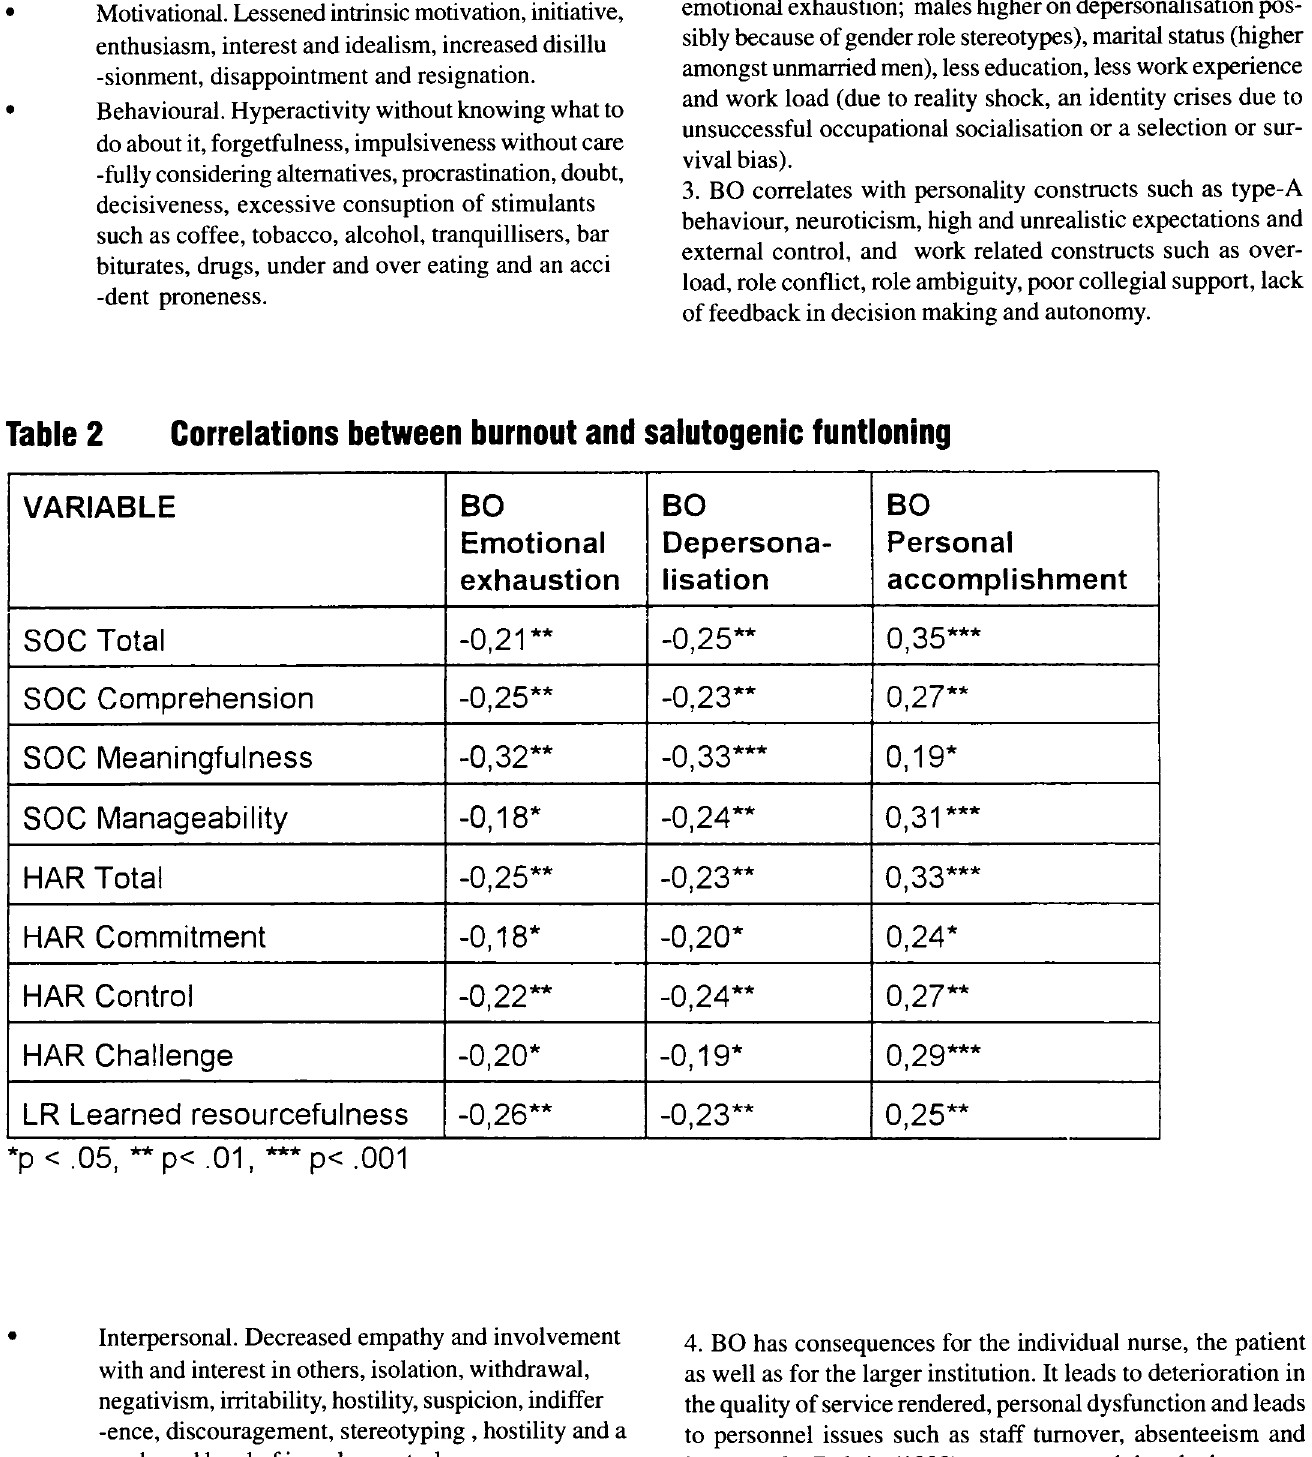
Correlations between burnout and salutogenic funtloning